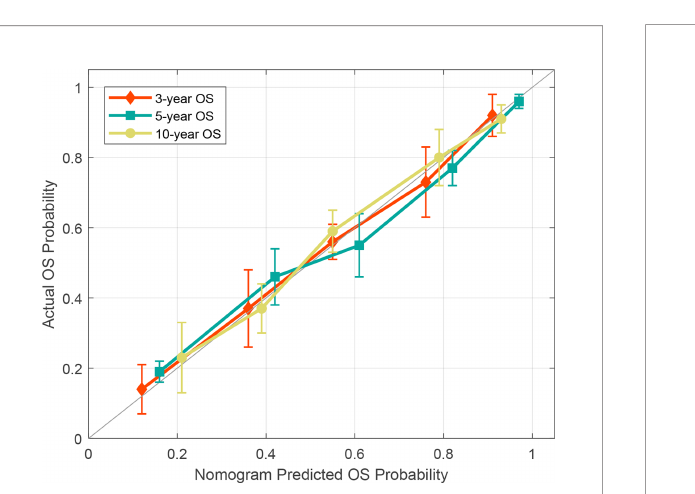
FIGURE 8 | Decision curves for the validation cohort comparing the ability of nomograms to predict overall survival (OS) probability in patients with